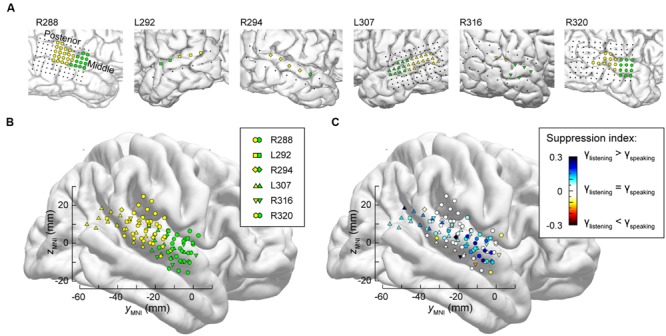
Anatomical parcellation of STG and summary of SI analysis. (A) MRI views showing the locations of recording contacts chronically implanted over STG in all subjects. Recording sites assigned to posterior and middle STG ROIs as described in text are shown in yellow and green, respectively. Recording sites on the subdural temporal grid arrays that were excluded from analyses on anatomical grounds are depicted as black dots. (B) Locations of all posterior and middle STG sites (yellow and green symbols, respectively) plotted in MNI coordinate space and projected onto FreeSurfer average template brain. Different symbol shapes correspond to different subjects. (C) Color-coded SI values (threshold ± 0.05), plotted in MNI coordinate space and projected onto FreeSurfer average template brain. Different symbol shapes correspond to different subjects.